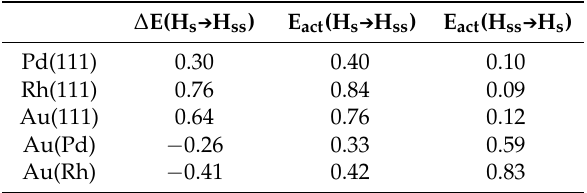
Figure 4. Potential energy for a hydrogen absorption process as a function of the hydrogen distance from the surface (z). The energy reference corresponds to the adsorption of hydrogen in the hollow-fcc site. The corresponding snapshots of the process are shown at the right hand side. Table 5. Reaction and activation energy for hydrogen diffusion from the surface (s) to the subsurface (ss) and vice versa on the bimetallic systems (Au(Pd) and Au(Rh)) in comparison with previous calculations of the literature for Pd(111) and Au(111) [39]. All values are in eV.